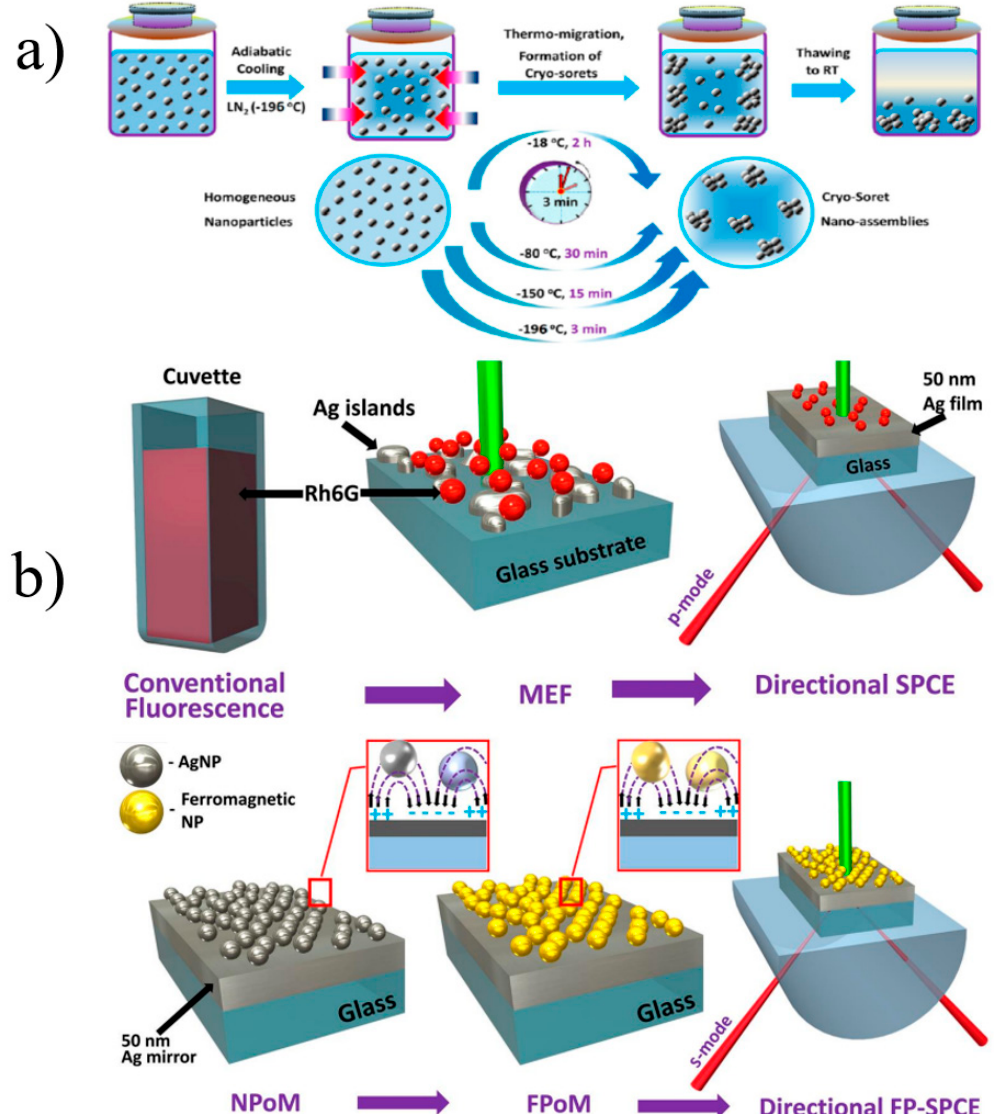
Figure 35. ( a ) A conceptual schematic of the Soret nanoassembly synthesis [141]. ( b ) Progression from conventional fl uorescence to MEF and to directional SPCE and progression from